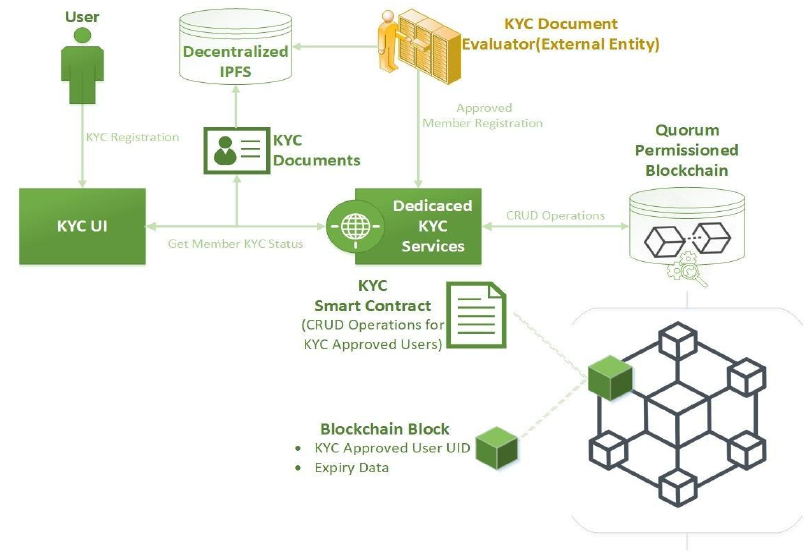
Figure 1. Architectural development and processes elaboration.